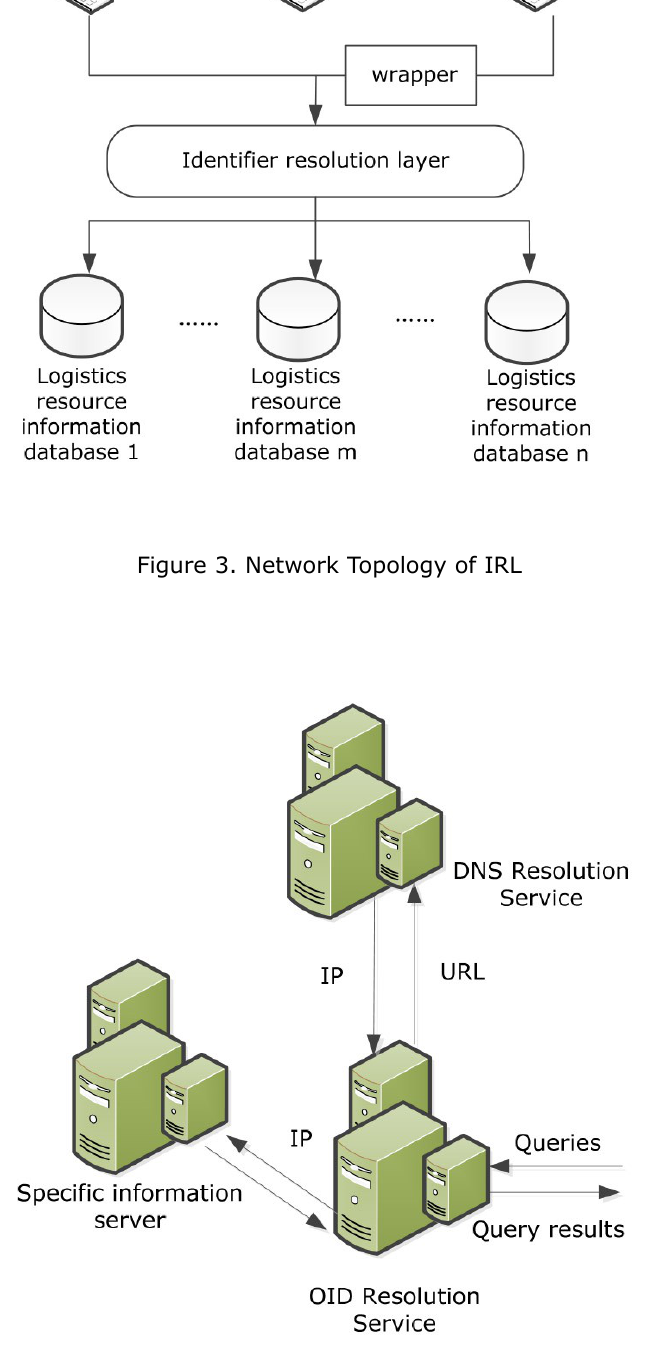
Figure 4. Structure Diagram of IRLIn